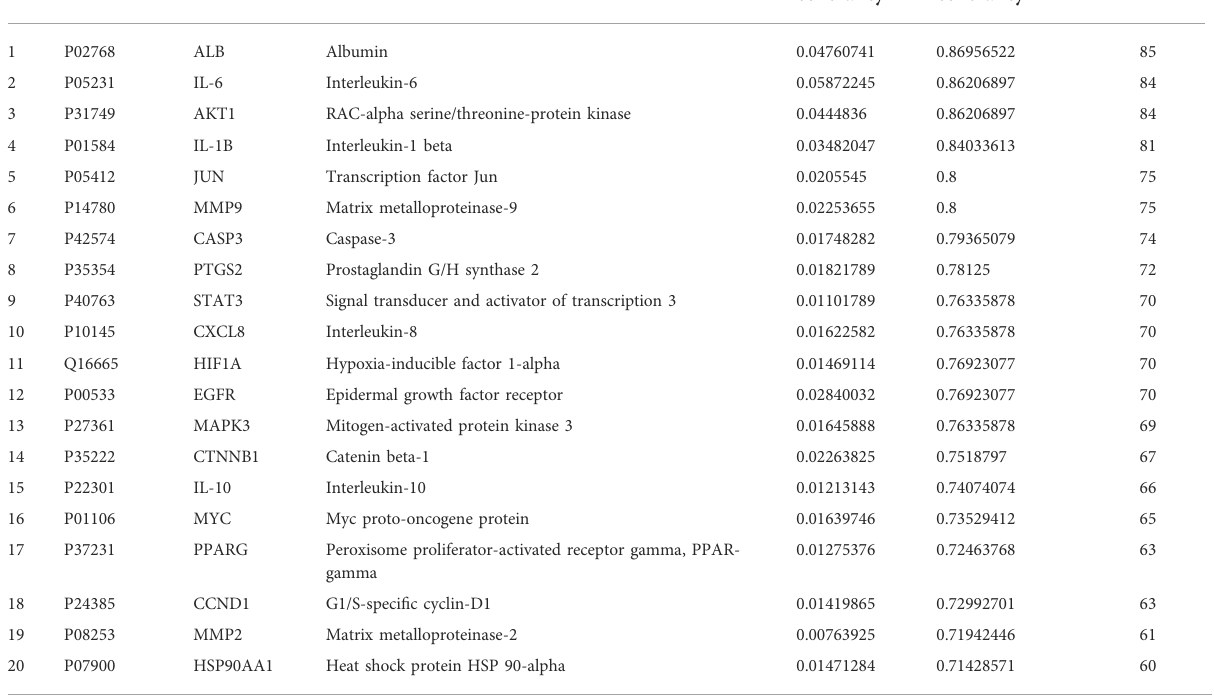
TABLE 3 Top 20 key targets of Huangqi Jianzhong decoction.